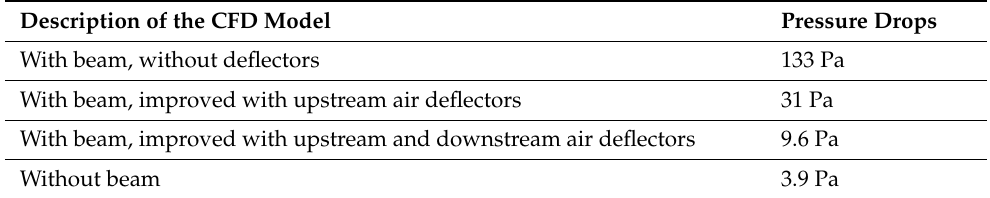
Table 4. Total pressure drops for a beam size of 288 mm and an air inlet velocity of 7.9 m/s (the height of the beam is less than half of the ventilation duct height).